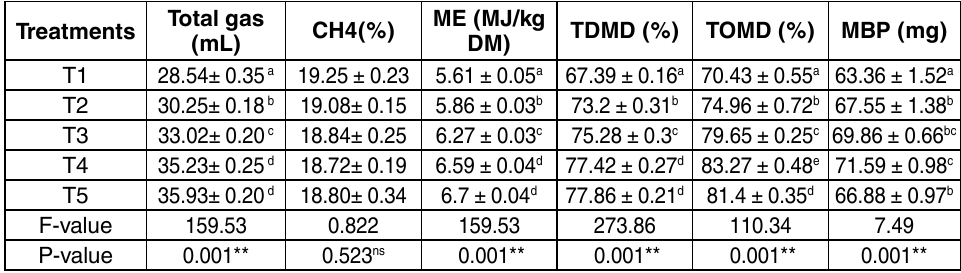
Table 3. In vitro gas production and fermentation parameters of TMR supplemented with biotin in cross bred cows Treatments